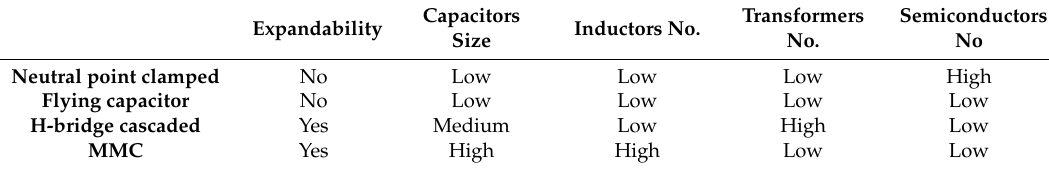
Figure 4. Multi-level topologies: ( a ) Three-level neutral point clamped; ( b ) Three-level flying capacitor converter; ( c ) Cascaded H-bridge converter; ( d ) Modular multilevel converter [58]. Table 1. Comparison of various multi-level topologies.